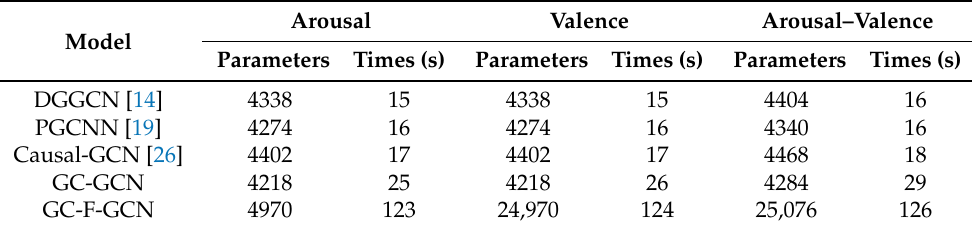
Table 5. The parameter numbers of network and average training time of different GCN scheme.